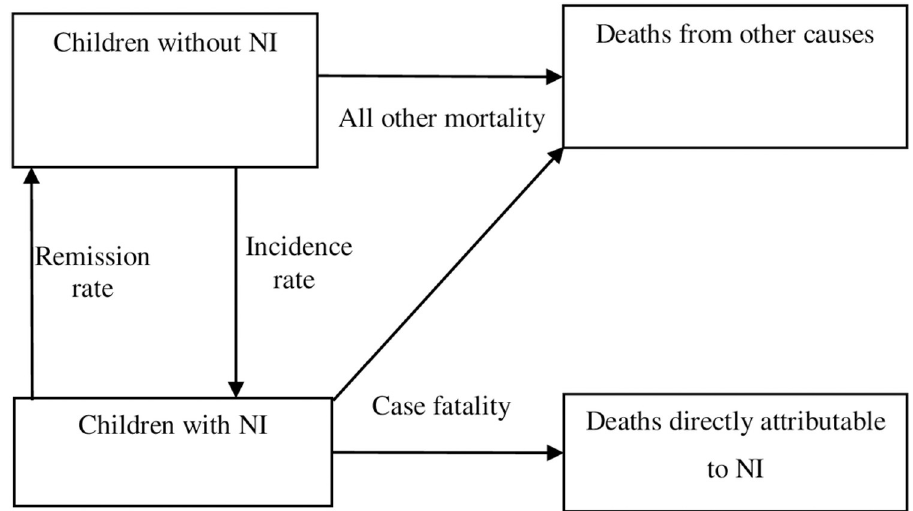
Fig 1. The conceptual model for neurological impairment in DisMod II illustrating three health states and the transitional hazards—incidence, remission, case fatality, and all other mortality.